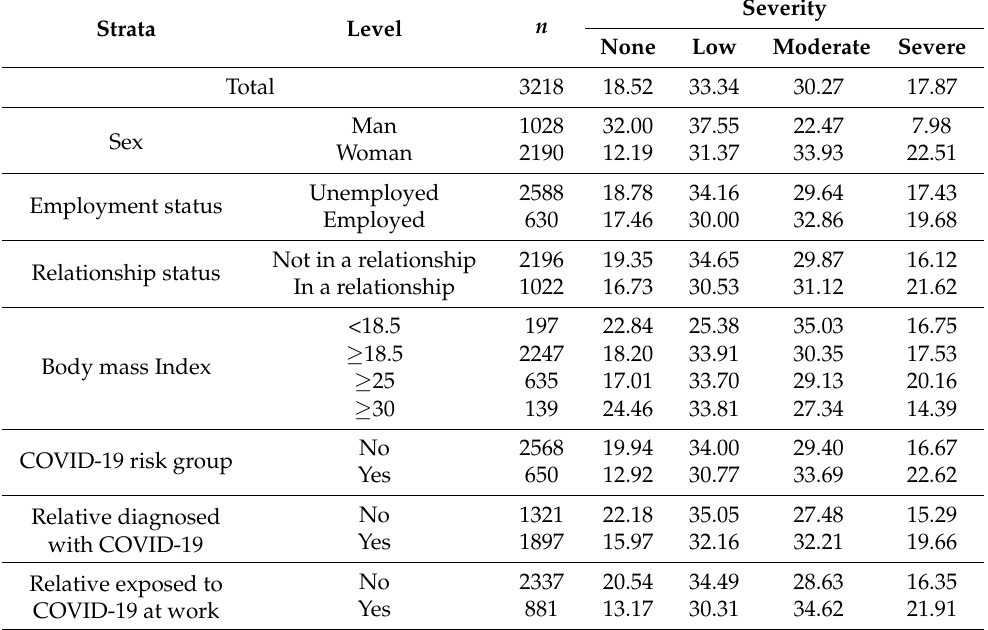
Table 1. Severity of Somatic Symptoms by Sociodemographic Groups.